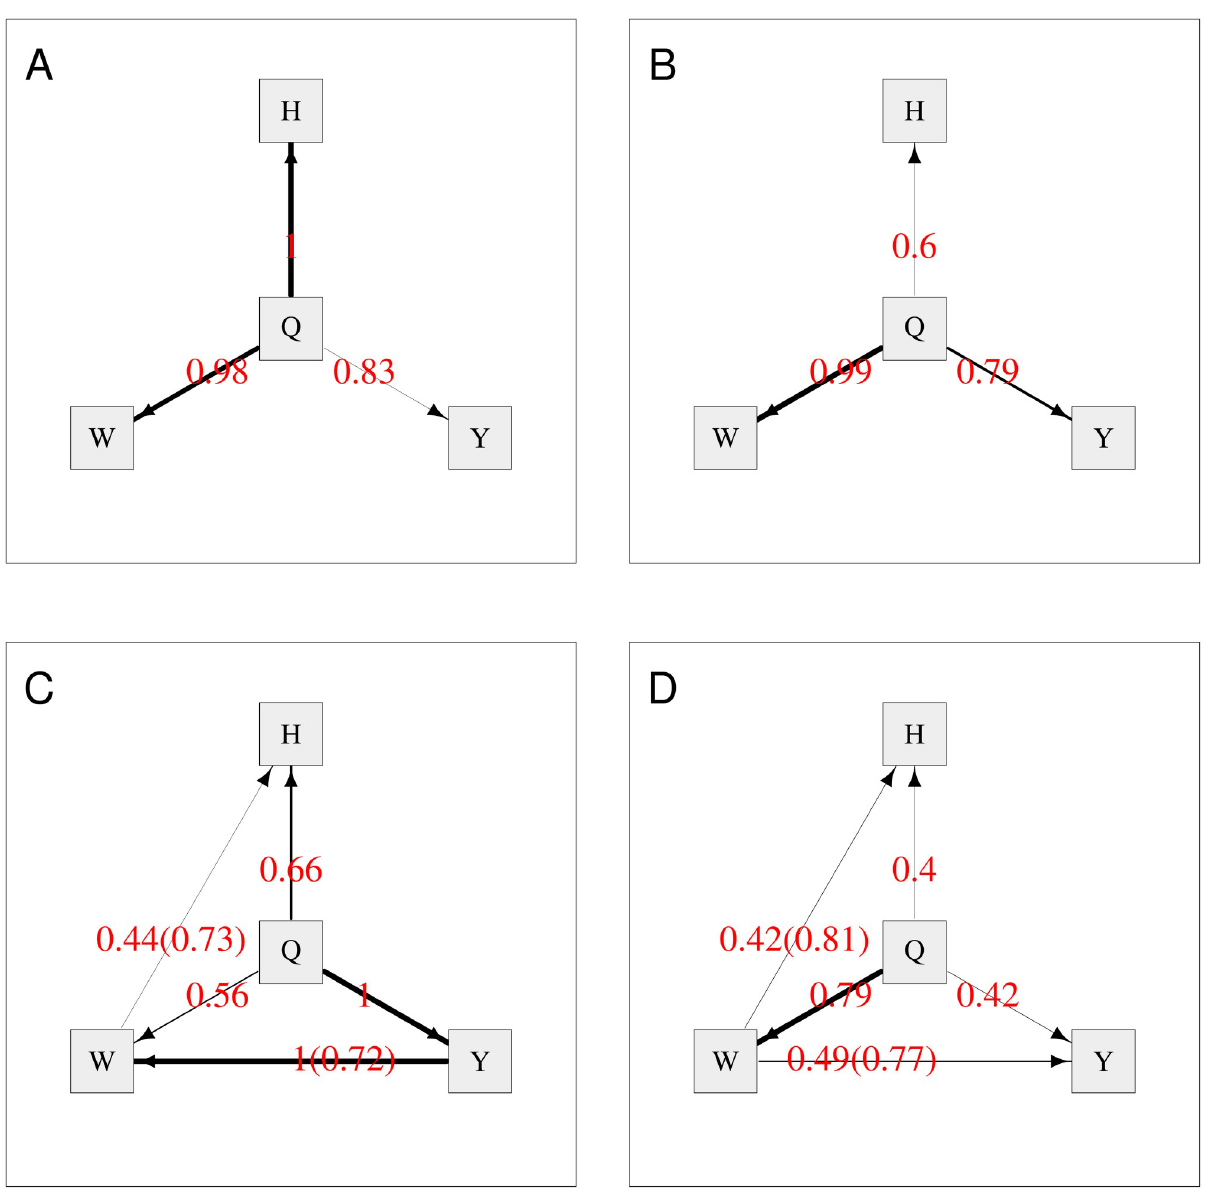
Fig 8. Average Bayesian networks for each of the four scenarios (A–D) used for the simulated binary data. The red numbers indicate the probability of existence of an edge, and the numbers in brackets indicate the probability of the edge operating in direction shown, given that it exists. The thickness of the edges indicates their strength (probability of existence). G is constrained to have no